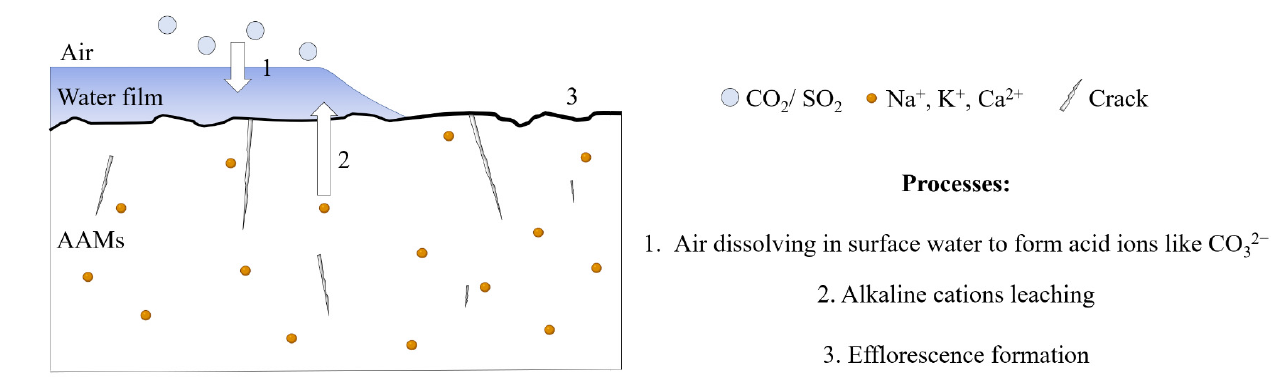
Figure 1. The efflorescence formation process.